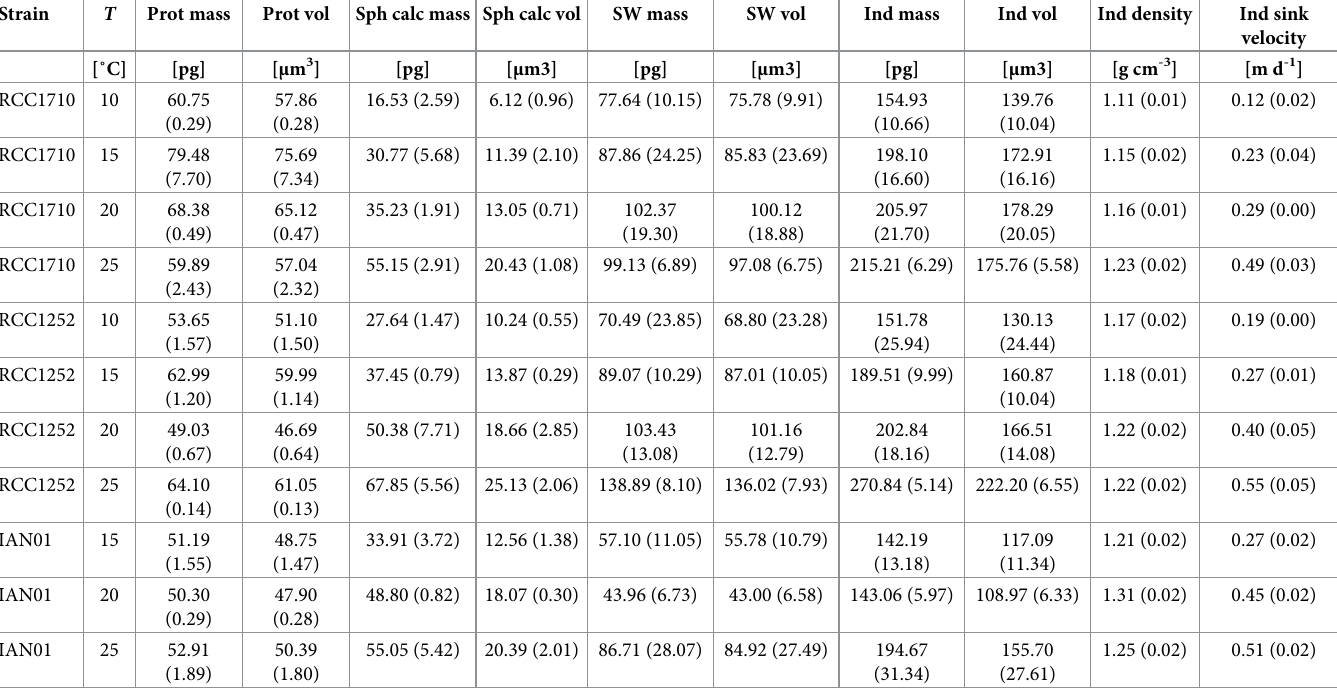
Calculated masses and volumes involved in the estimations are shown. Standard deviation of the triplicates is shown in parentheses. Temperature ( T ); protoplast (prot); volume (vol); coccosphere (sph); calcite (calc); extracellular matrix seawater (SW); individual (ind); sinking (sink).